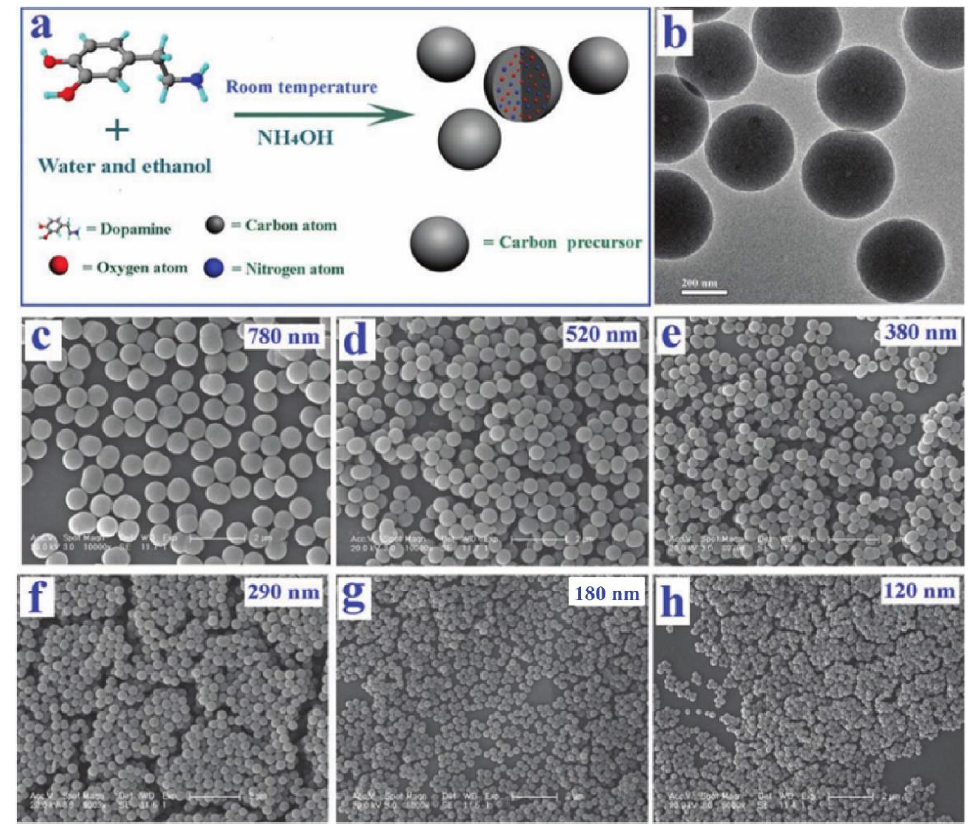
Figure 3. PDA nanoparticles of various sizes. ( a ) Schematic illustration of the synthesis of PDA SMSs. ( b ) Typical TEM image of PDA SMSs with an average diameter of 380 nm. ( c – h ) SEM images of PDA SMSs with different diameters prepared at different ratios of ammonia to dopamine [37].